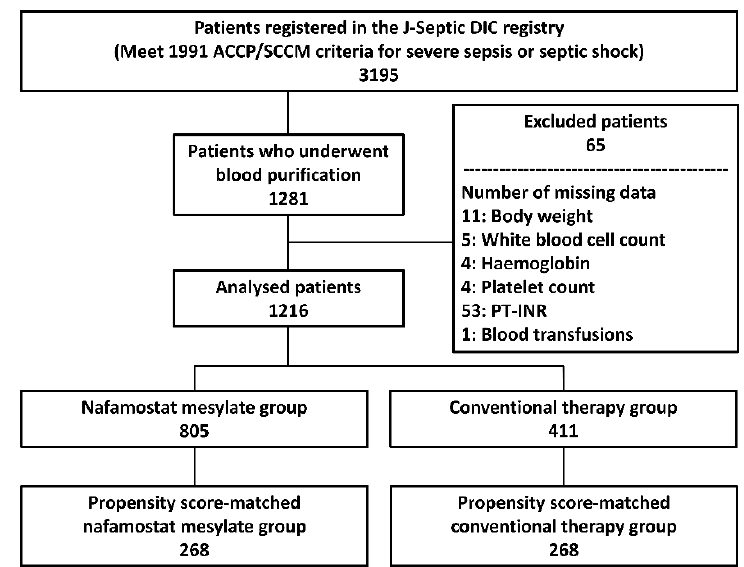
Figure 1. Study flowchart. Numbers of patients are indicated in each box. ACCP: American College of Chest Physicians; J-Septic DIC: Japan Septic Disseminated Intravascular Coagulation; PT-INR: Prothrombin time international normalized ratio; SCCM: Society of Critical Care Medicine.